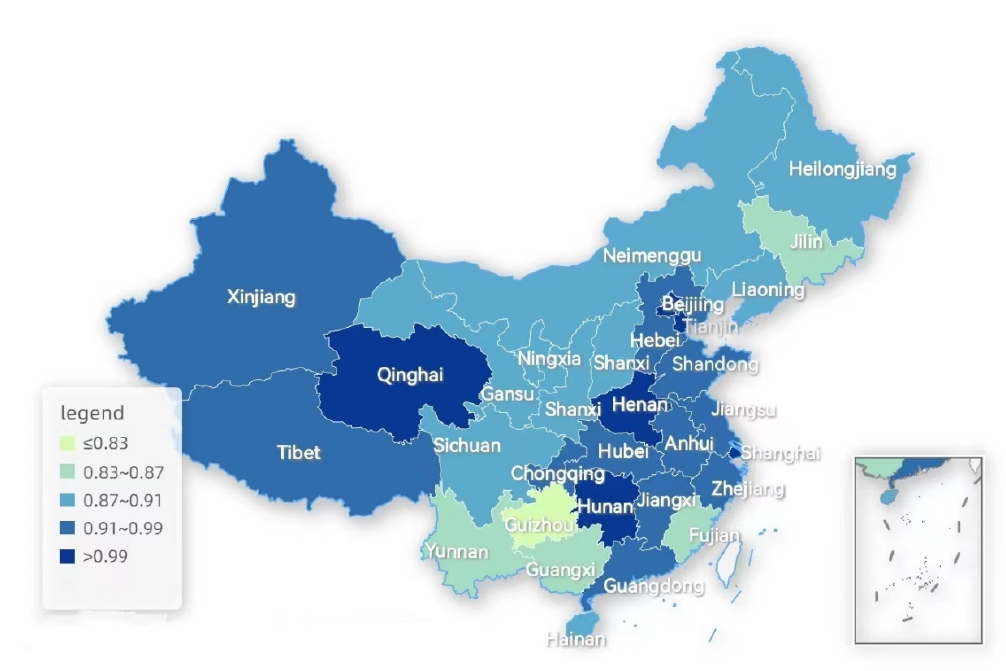
Figure 5. Adjusted efficiency of the basic medical insurance in 31 provinces of China.